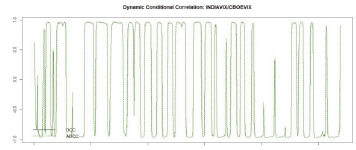
Fig. 5. Dynamic Conditional Corre- lation at D6